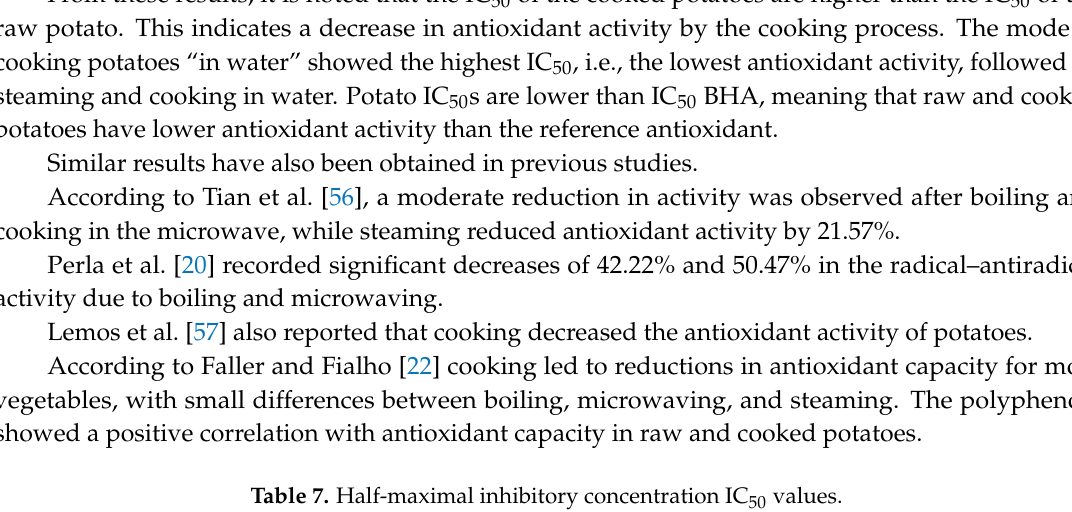
Table 7. Half-maximal inhibitory concentration IC 50